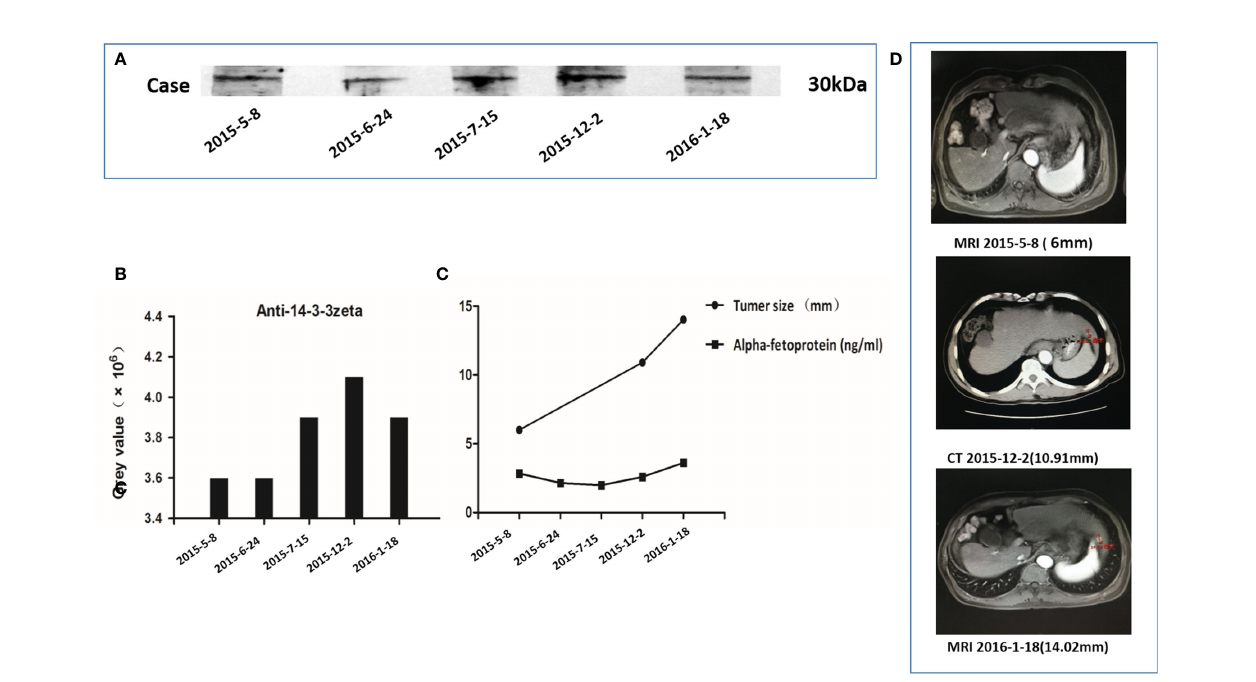
FIGURE 4 | Autoantibody to 14-3-3 zeta in serial serum samples from an alpha-fetoprotein (AFP)-negative hepatocellular carcinoma (HCC) patient. (A) The HCC patient was diagnosed on January 18, 2016, with a strong 14-3-3 zeta reactive band. (B) During a 9-month period (May 8, 2015, to January 18, 2016), fi ve serum samples obtained from this patient showed a gradual increase in the 14-3-3 zeta reactive band. A stronger reactive band could be observed in the serum 9 months before the diagnosis of HCC. (C) The trends in gray values of fi ve serum sample reactive bands were compared with 14-3-3 zeta and AFP values in fi ve serum samples, as well as the tumor nodule size, at three corresponding time points. The gray values and tumor sizes corresponding to the serial serum samples show the same increasing trend. No signi fi cant trend in AFP values among the fi ve serum samples was observed, and these values were less than the upper limit of the normal level. (D) Imaging data of three corresponding time points of serial serum sampling shows that the size of the nodule gradually increased from 6 to 14.02 mm and was subsequently proven to be a tumor